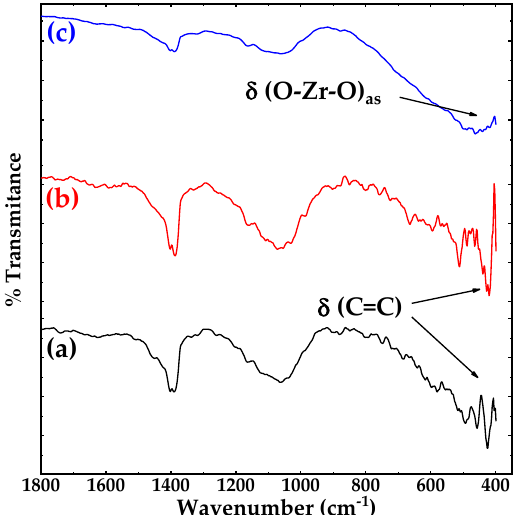
Figure 2. FTIR spectra of ( a ) pristine CNTs, ( b ) functionalized CNTs and ( c ) ZrO 2 -fCNTs in a range from 1800–400 cm −1 .